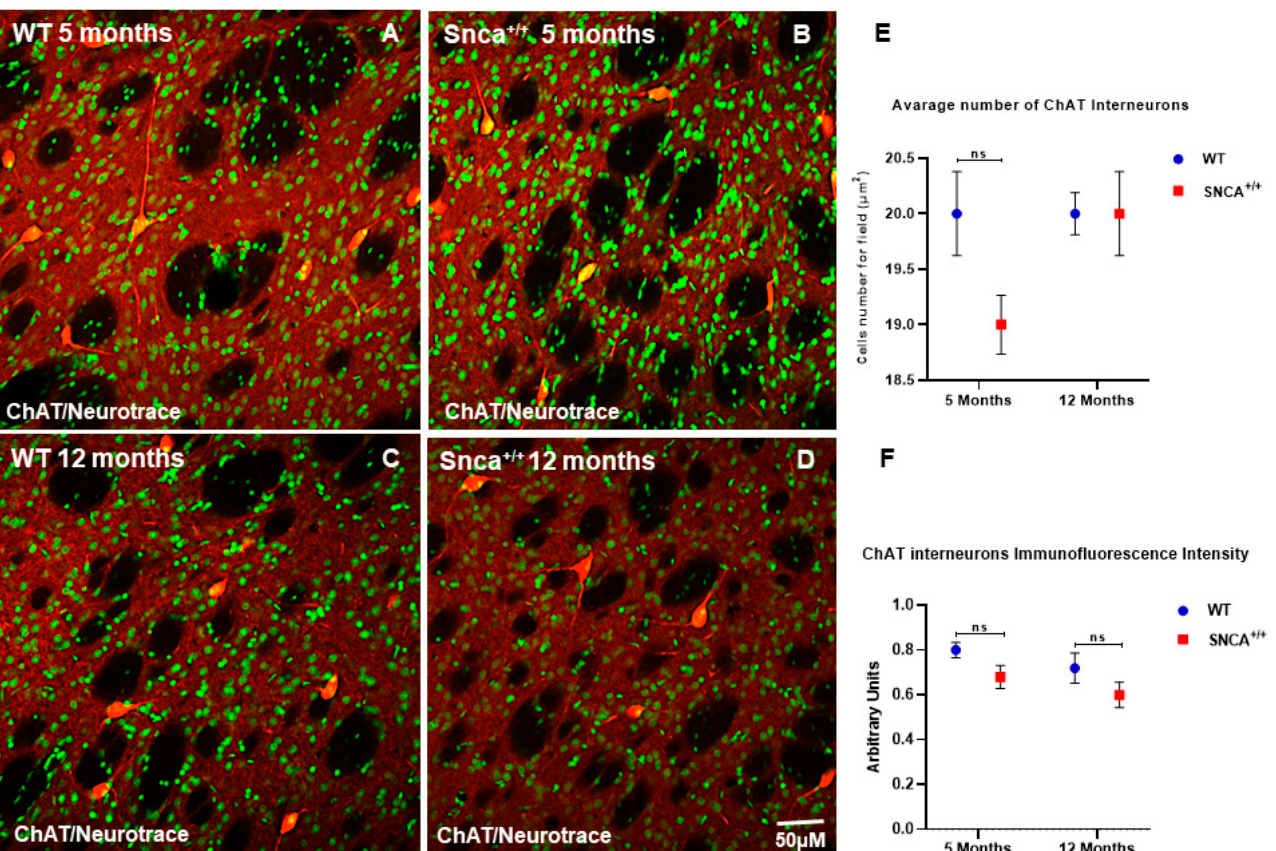
Figure 2. ChAT Interneuron Distribution. Confocal microscopy-acquired images of single-label immunofluorescence for ChAT and counterstained with fluorescent Nissl staining. ChAT is shown in red fluorescence, Neurotrace is labeled in green. ( A – D ) Images show the immunoreaction intensity of ChAT in each experimental group. ( E , F ) Two-way ANOVA analysis performed on data obtained from 5- and 12-month-old WT and Snca +/+ showed no statistically significant (ns) change in ChAT-positive neurons and intensity.